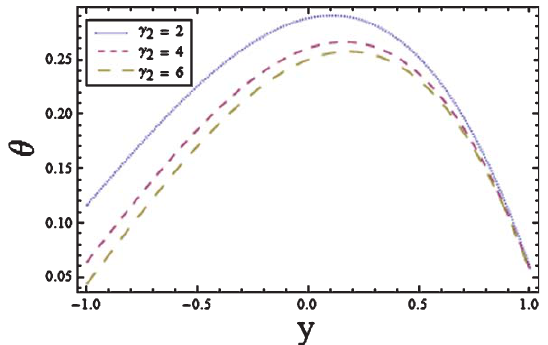
Fig. 8. Plot of the temperature θ for various values of the Biot number γ 2 with (cid:15) = 0 . 2, x = 0 . 1, t = 0 . 1 ,Sc = 1 , Sr = 2 ,Du = 2 , γ = − 1 . 5 , Pr = 1 . 5 and γ = 1 Fig. 5. Plot of the temperature θ for various values of the Dufour number Du with (cid:15) = 0 . 2, x = 0 . 1, γ = − 1 . 5, t = 0 . 1 , Sc = 0 . 4 , Sr = 2 , γ = 10 , Pr = 1 . 5 and γ = 8 . 1 2